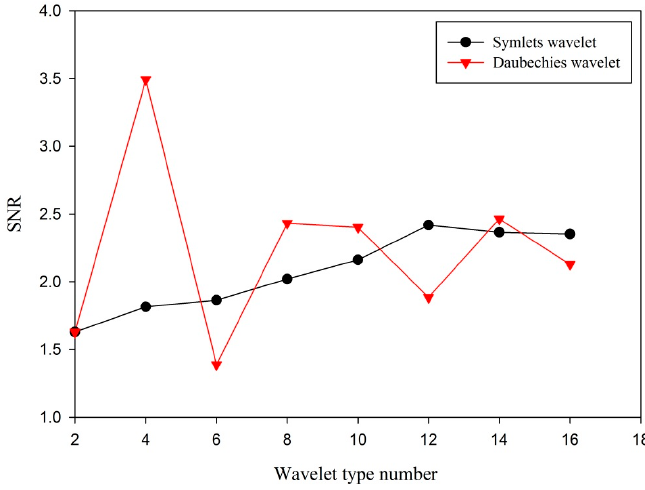
Figure 5. The comparison of vibration signal de-noising performance based on different wavelets.